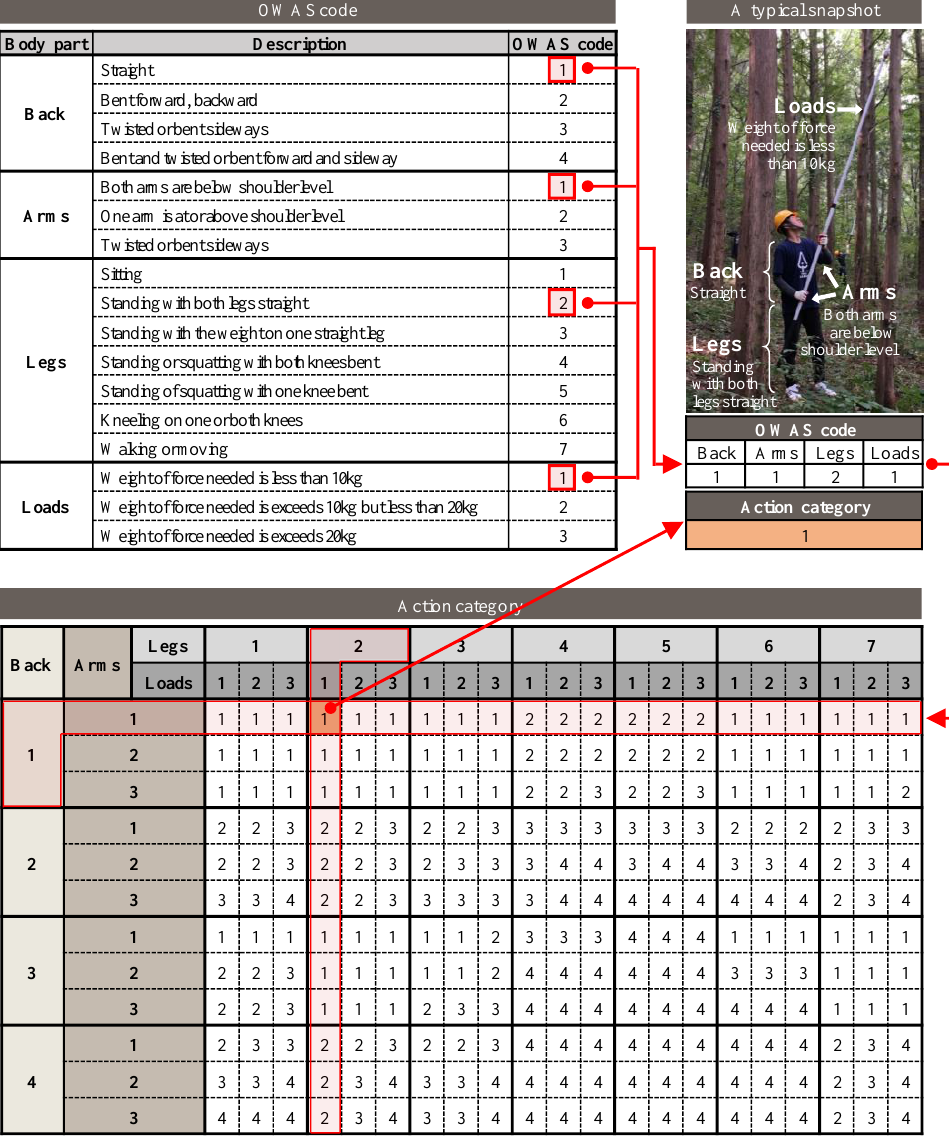
Figure 4. The concept behind Ovako Working posture Assessment System.